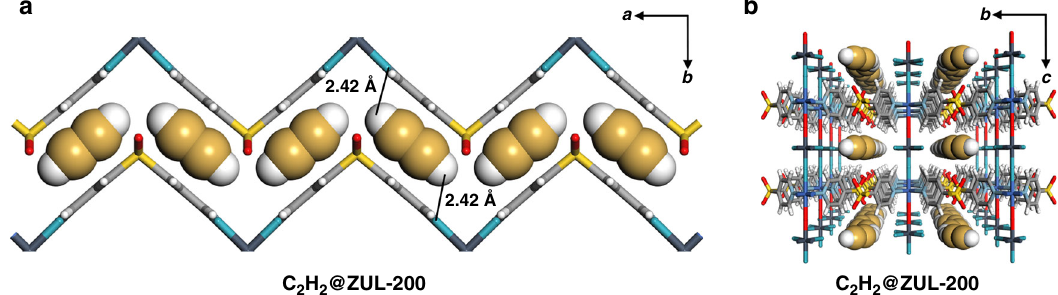
Fig. 4 The single crystal structure of C 2 H 2 @ZUL-200. a The single crystal structure of ZUL-200 under C 2 H 2 (C 2 H 2 @ZUL-200) at ultralow pressure viewed along the c axis. C 2 H 2 molecules are trapped in interlayer space with dual C – H···F hydrogen bonds (2.42 Å). b The single crystal structure of C 2 H 2 @ZUL-200 viewed along the a axis (Color code: F, teal; Nb, plain blue; C (in framework), gray; H, white; N, sky blue; S, yellow; O, red; Cu, blue; C (in C 2 H 2 ),